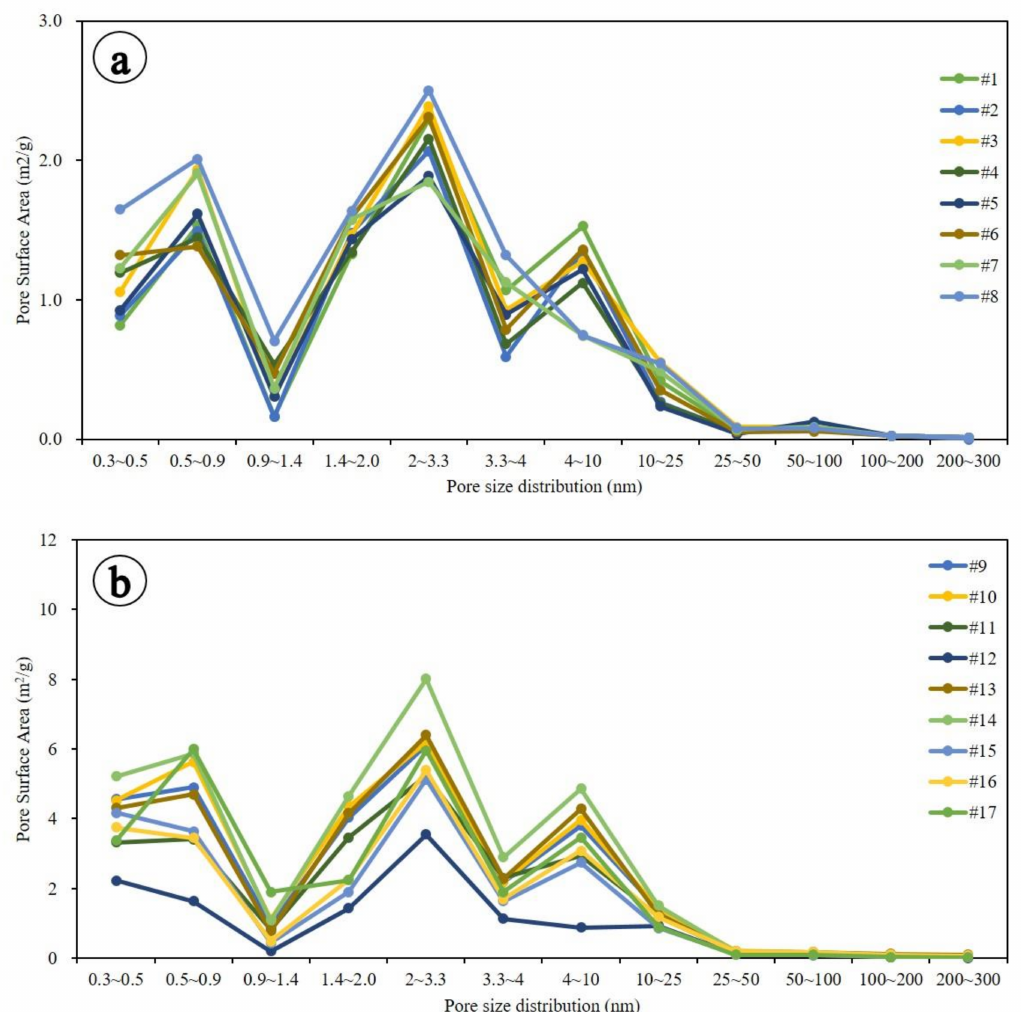
Figure 6. The PSAs of lower Cambrian shale and lower Silurian shale samples analyzed by N 2 adsorption experiments: ( a ) PVs of lower Cambrian shale samples (#1–#8) and ( b ) PSAs of lower Silurian shale samples